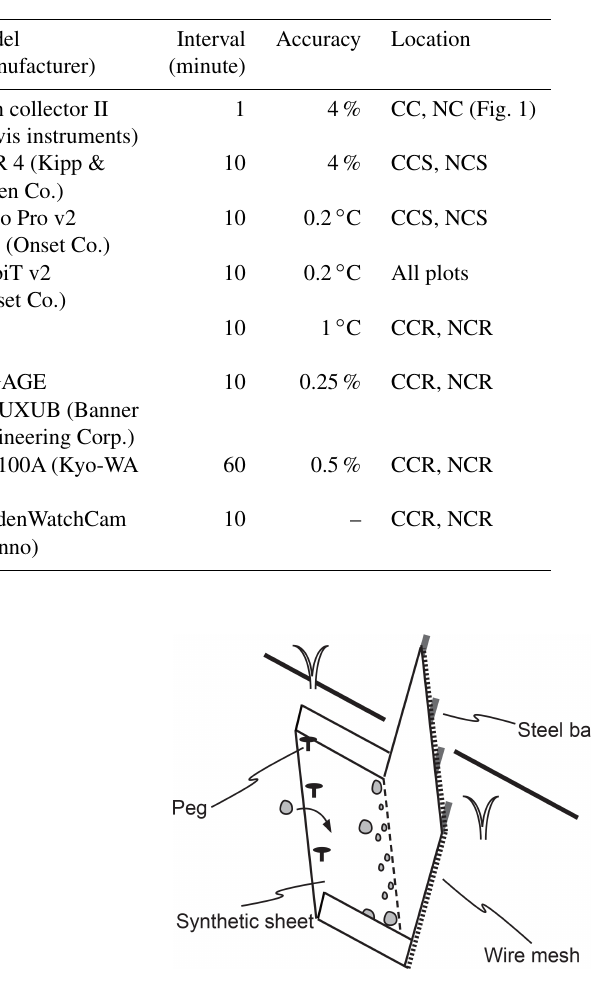
Table 3. List of monitoring devices.